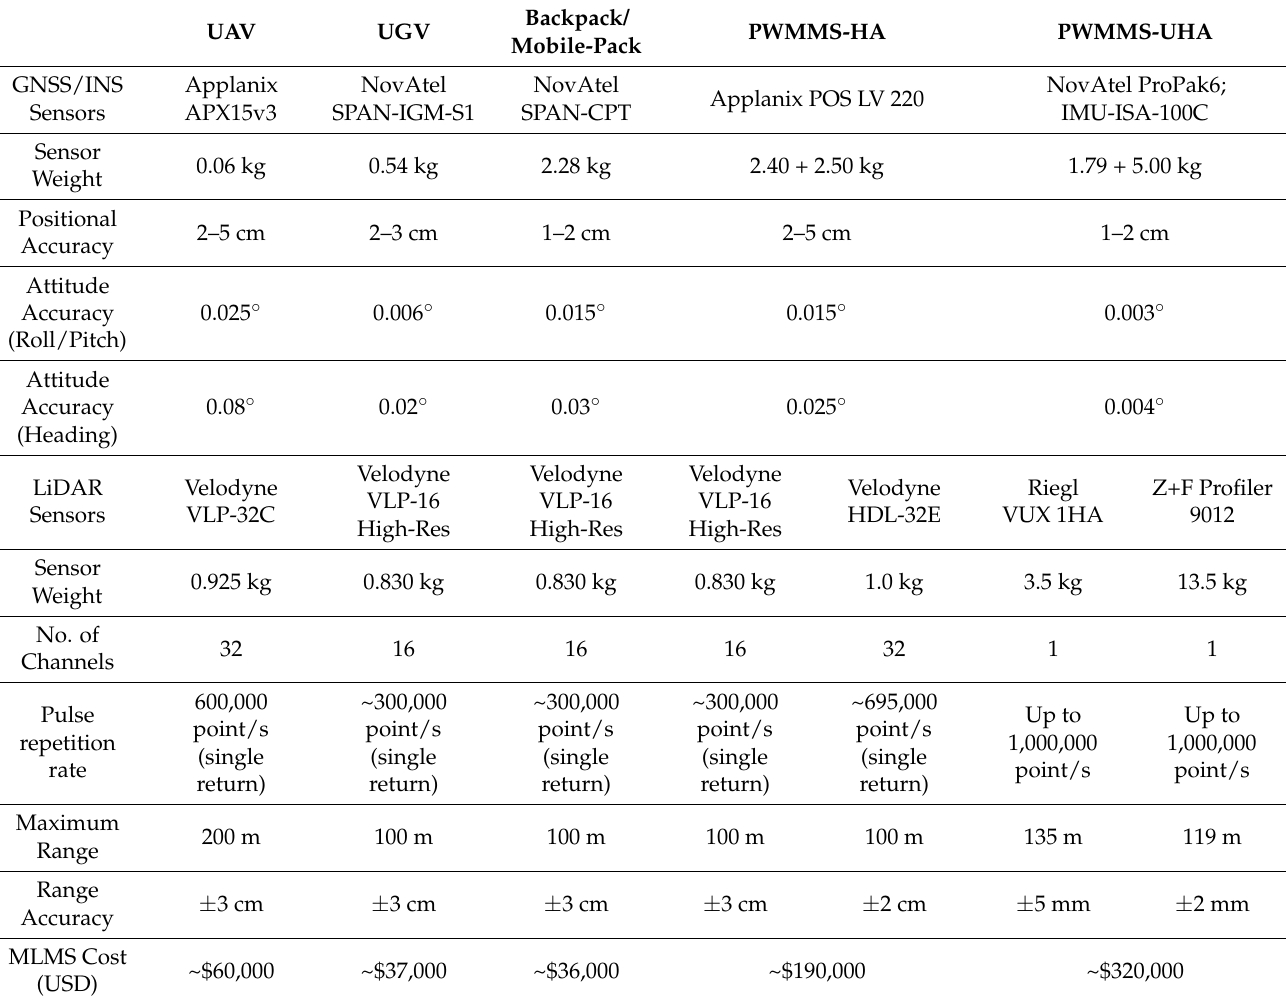
Table 1. Specifications of the georeferencing and LiDAR sensors for each mobile LiDAR mapping system (MLMS) including the approximate total